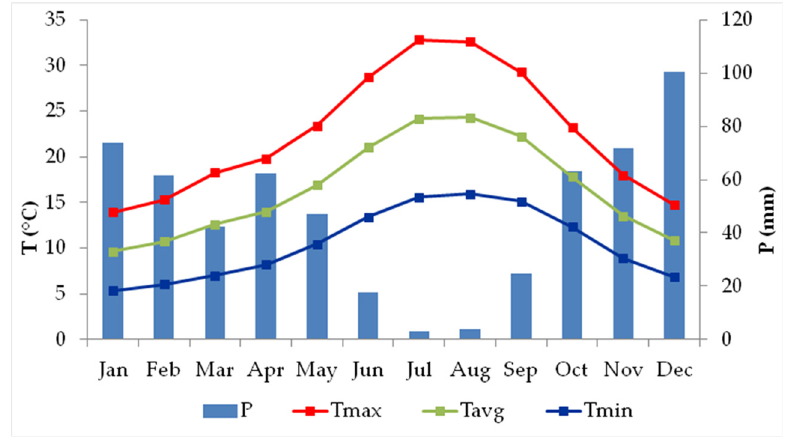
Figure 2. Climate normals relative to the 1971–2000 period at the Beja weather station for precipitation and maximum, average, and minimum air temperatures.